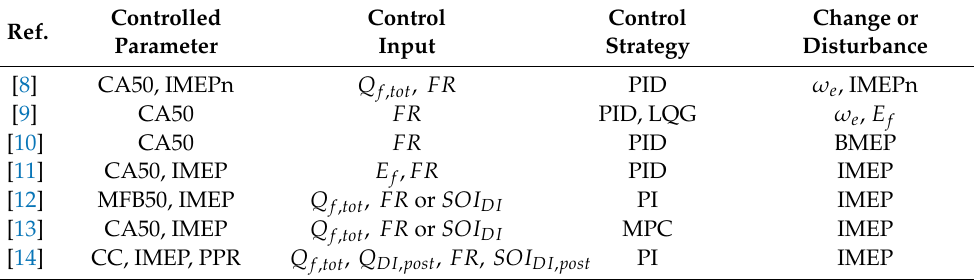
Table 1. Overview of experimental RCCI control studies. Abbreviations: FR—(mass- or energy-based) fuel ratio; CC—combustion centroid; MFB—mass fraction burned; DI—direct injection; SOI—start of injection; ω e —engine speed; Q f —fuel quantity; E f —fuel energy).